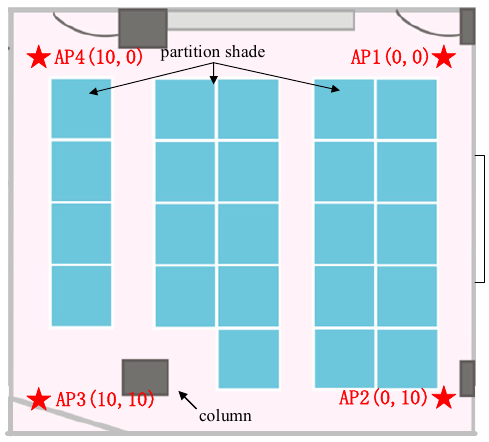
Figure 7. Deployment Wi-Fi access points (APs).